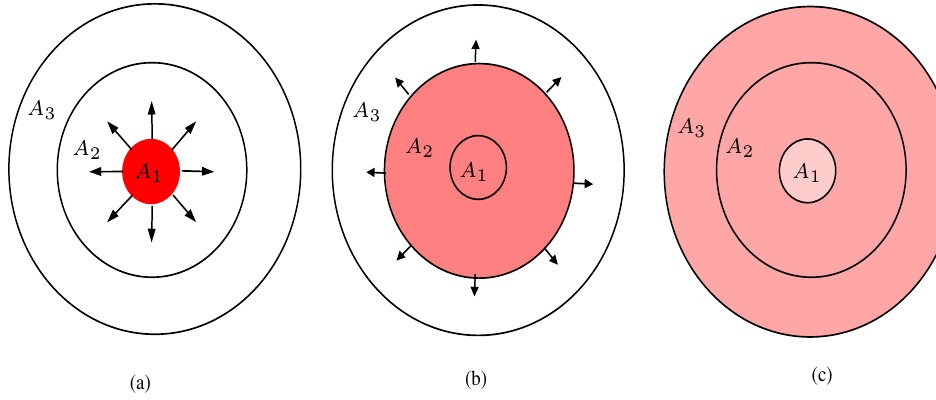
Figure 3. A macroscopic view of the congestion dissipation